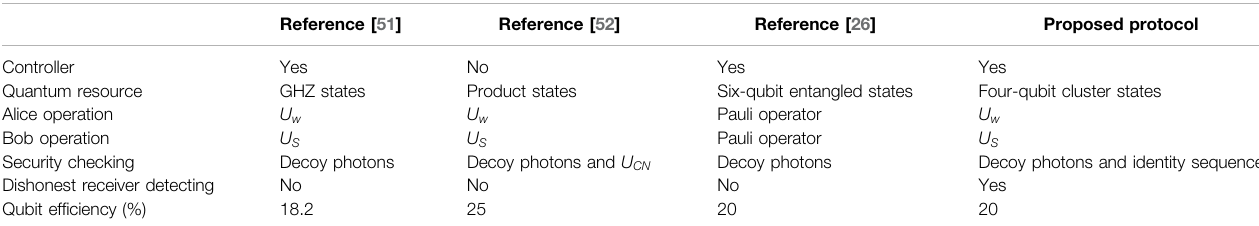
TABLE 3 | Performance comparisons between the proposed protocol and other